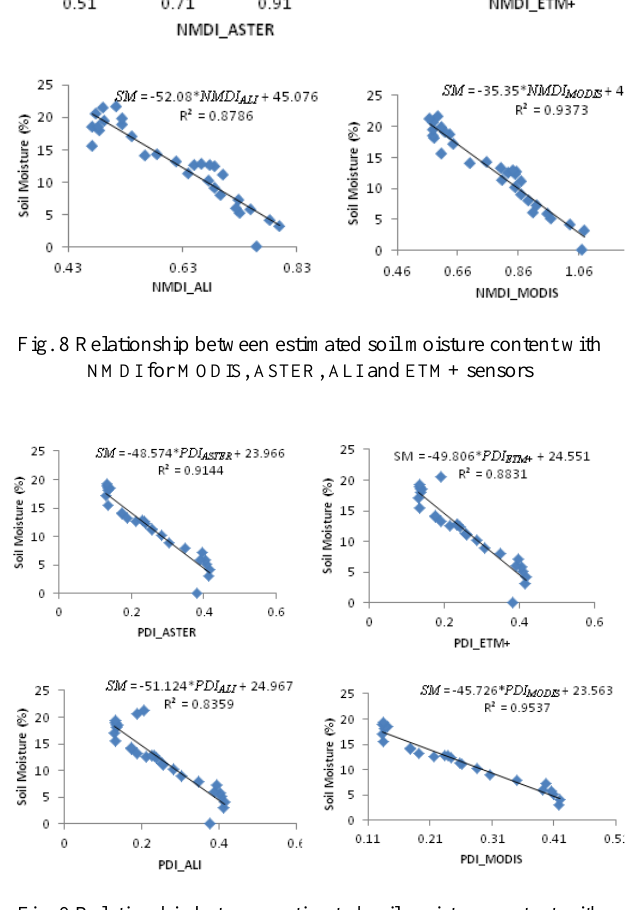
Fig. 9 Relationship between estimated soil moisture content with PDI for MODIS, ASTER, ALI and ETM+ sensors